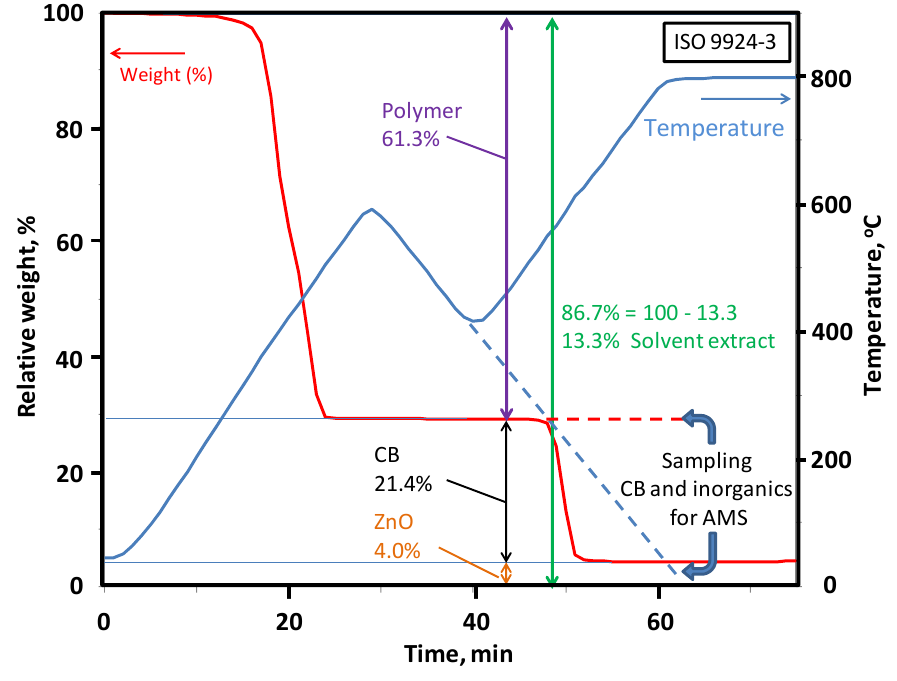
Figure 5. Composition ratio of rubber, CB, and inorganics of extracted model compound as determined by thermogravimetric